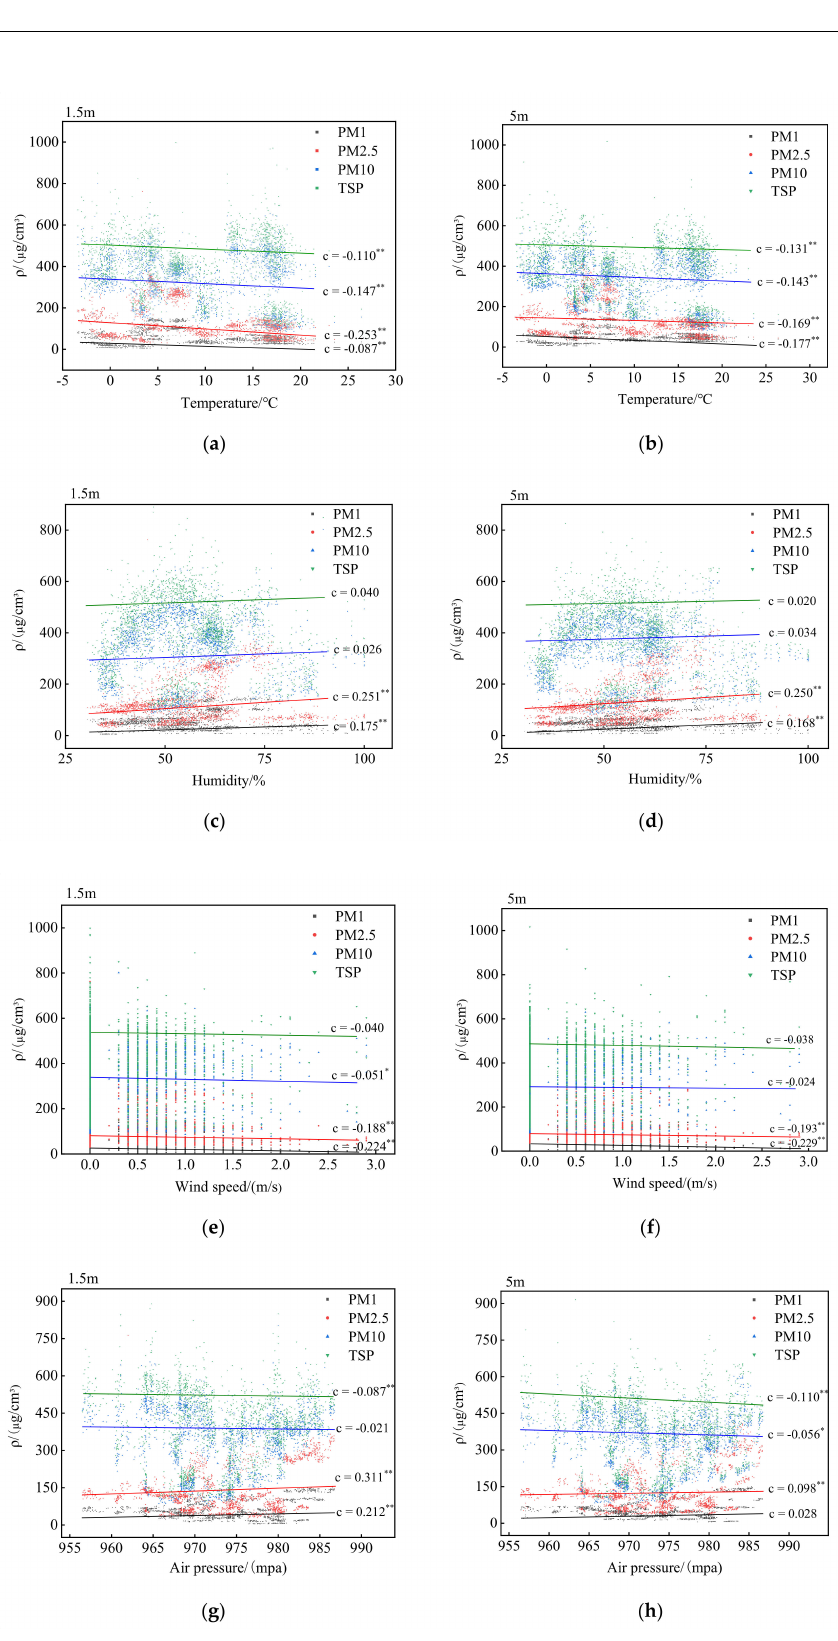
Figure 4. The relationship between meteorological factors and PM concentration in the different heights: ( a , b ) effect of temperature on the concentration of airborne particulate matter; ( c , d ) effect of humidity on the concentration of airborne particulate matter; ( e , f ) effect of wind speed on the concentration of airborne particulate matter; ( g , h ) effect of air pressure on the concentration of airborne particulate matter; “c” stands for correlation coefficient; **: at level 0.01 (two-tailed), the correlation was significant; *: at level 0.05 (two-tailed), the correlation was